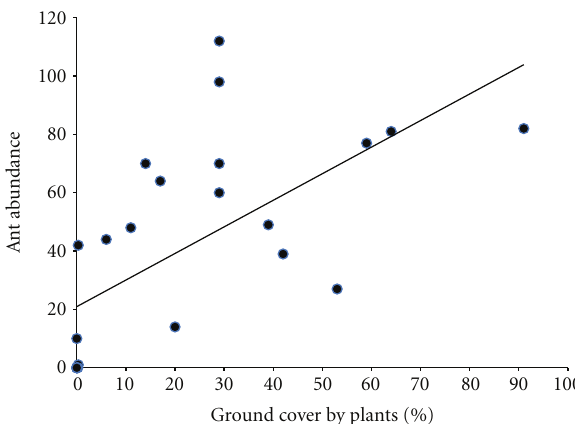
Figure 7: Relationship between percent ground cover by plants and ant abundance from samples collected at Mount St. Helens National Volcanic Monument between 22 and 25 July 2008. This relationship represents a significant positive correlation (Spearman rank correlation coe ffi cient = 0.787, P < 0 . 001). The equation for the fitted line is y = 0 . 9118 x + 20 . 925.